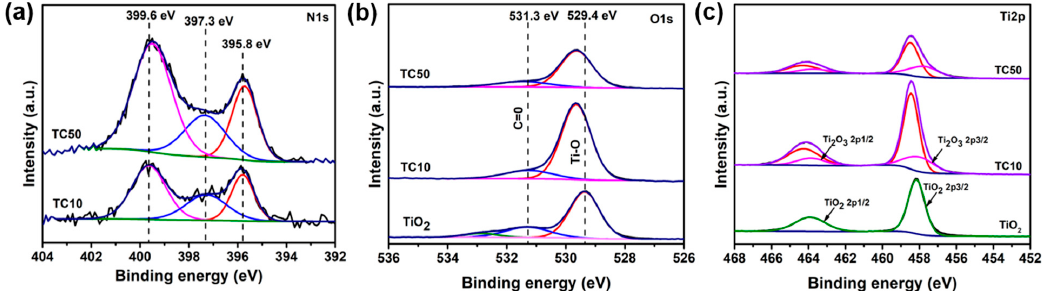
Figure 3. XPS spectra of pure TiO 2 P25, TC10, and TC50 ( a ) N1s, ( b ) O1s, and ( c ) Ti2p.